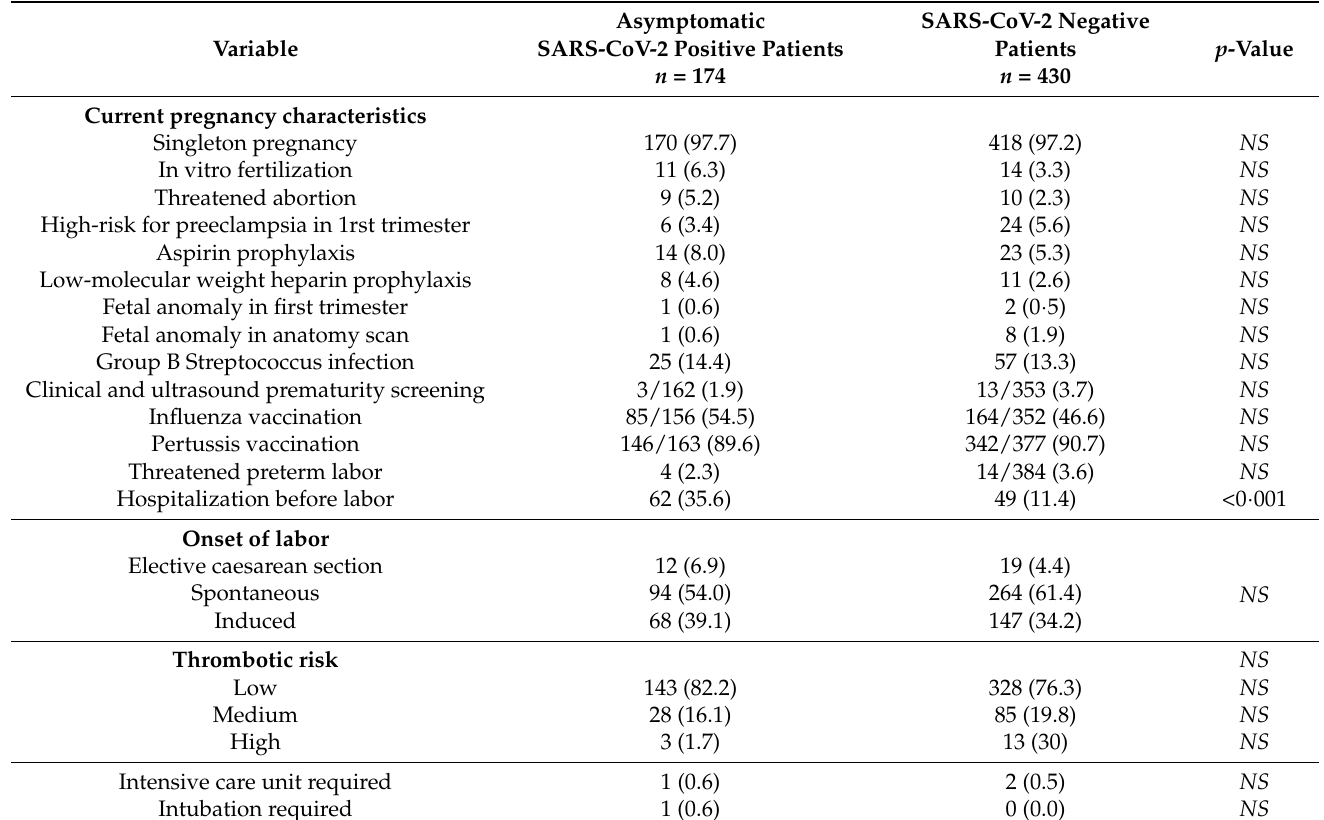
Table 2. Pregnancy characteristics of the study participants ( n =